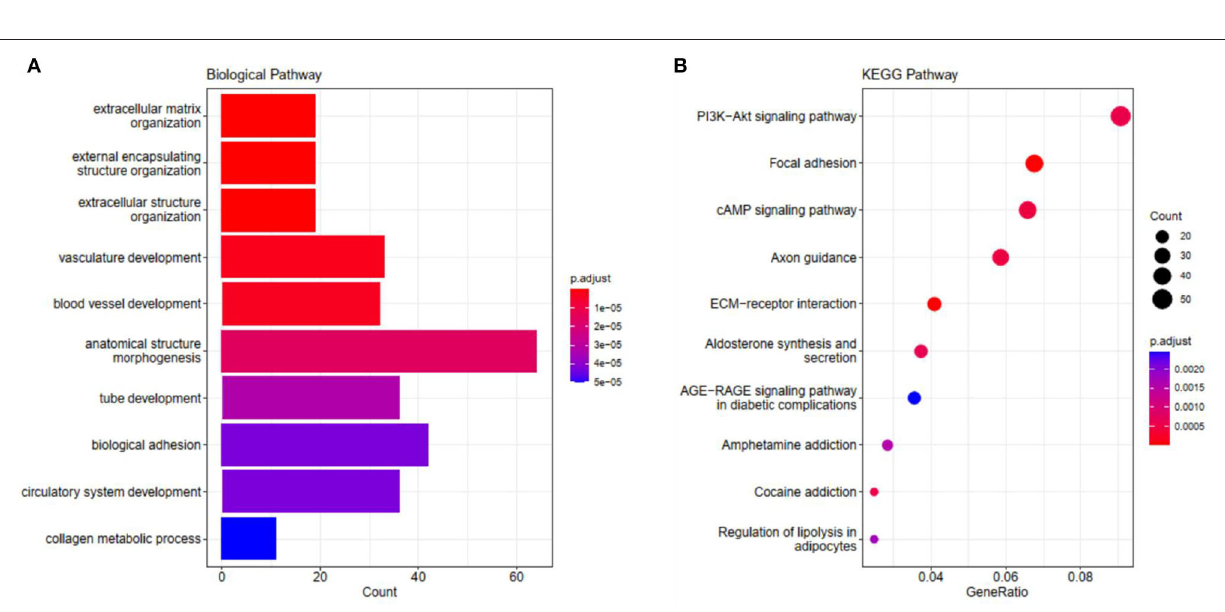
Frontiers in Veterinary Science |